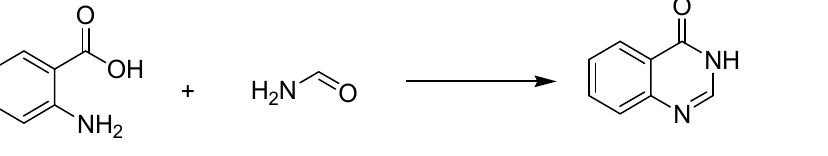
Figure 2. Synthesis of 3,4 dihydro-4-oxaquinazoline. Figure 1. 2-quinazolinone ( a ) and 4-quinazolinone ( b ).